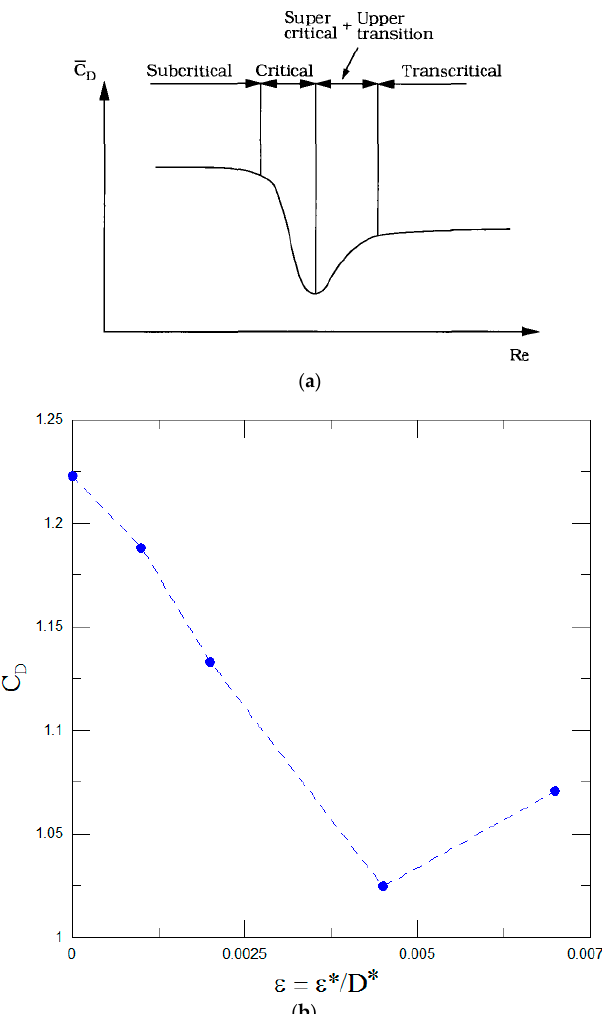
Figure 6. Flow regimes described by drag coefficient: ( a ) Classical representation of C D = C D ( Re ) curve for a cylinder (reproduced from [40] with permission; copyright © 2006 by World Scientific Publishing Co. Pte. Ltd.); ( b ) Form of C D = C D ( ε ) curve obtained by roughness model for a fixed Reynolds number (Re = 1.0 × 10 5 ).